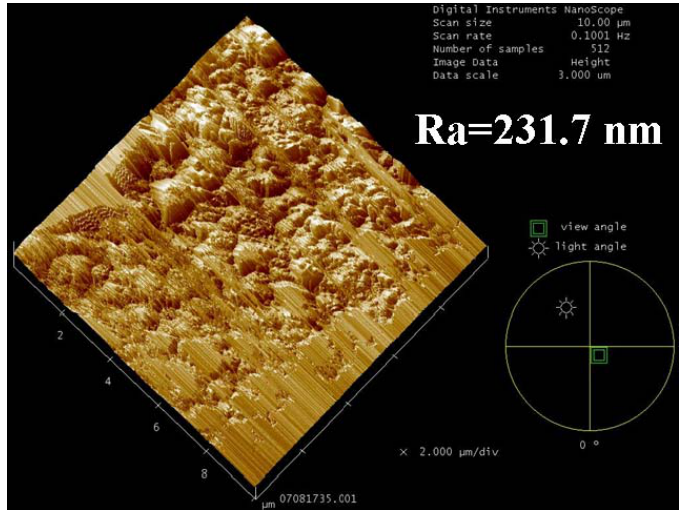
Figure 4 . AFM image of the exposed core surface (scanning area 10 μ m × 10 μ